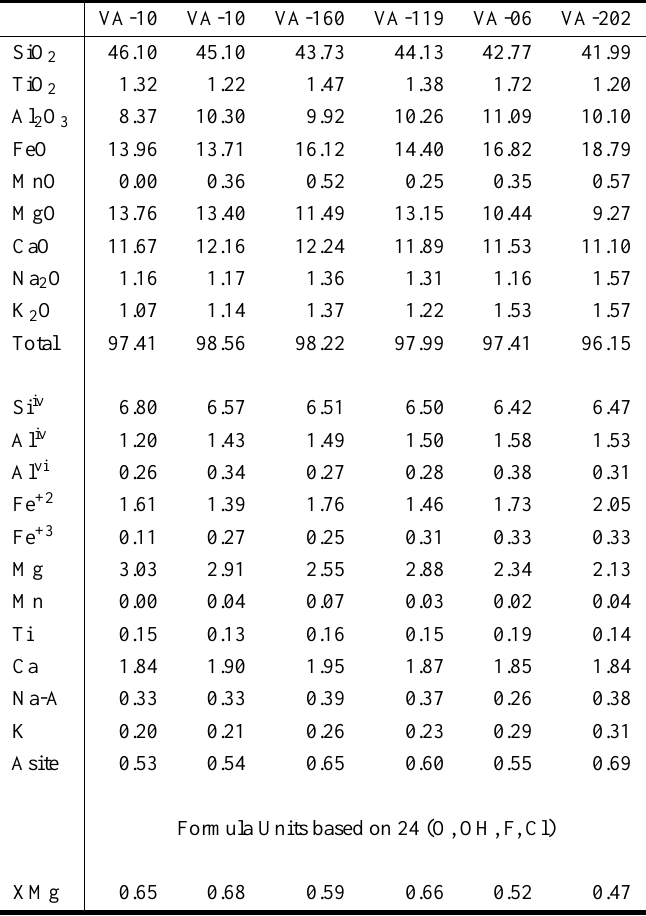
Representative Microprobe analyses of